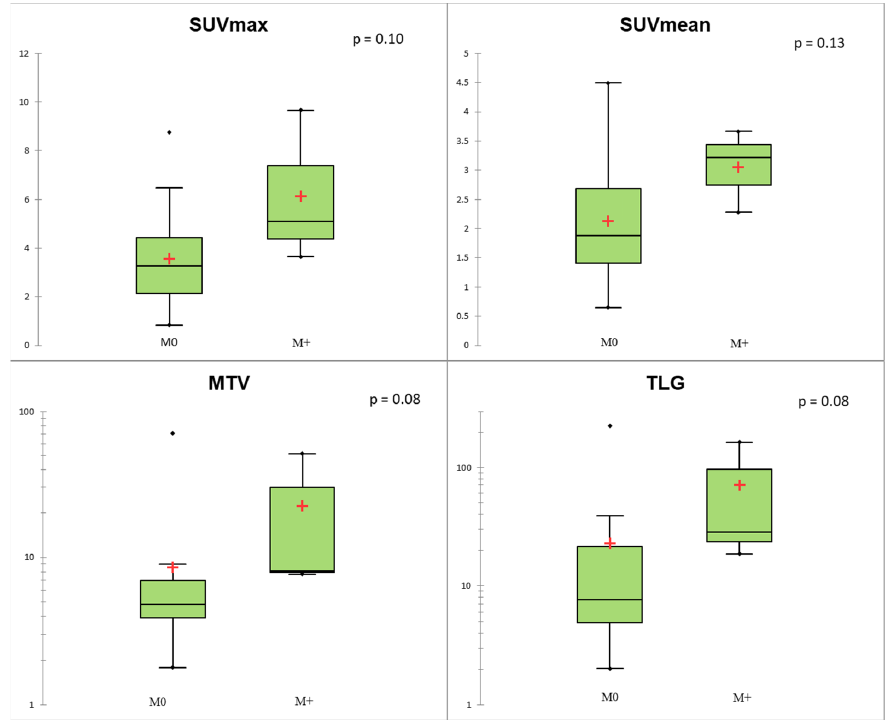
Figure 5. Conventional and volumetric parameters according to M status. The red crosses correspond to the mean value. The central horizontal bars correspond to the median value. The lower and upper limits of the boxes are the first and third quartiles. The error bars are the first decile and the ninth decile; the rhombuses are the minimum and maximum for each parameter.